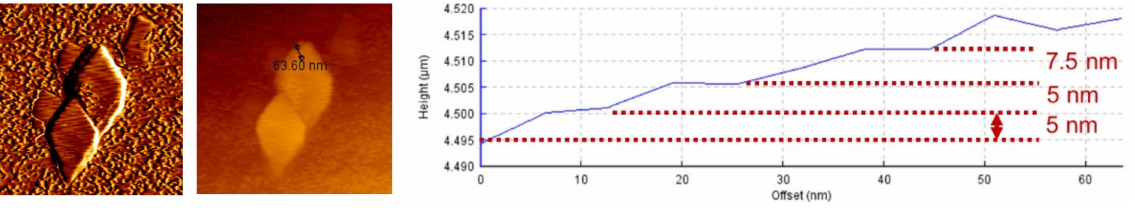
Figure 6. AFM results show the exfoliated flakes displayed approximate thickness of 5 nm.